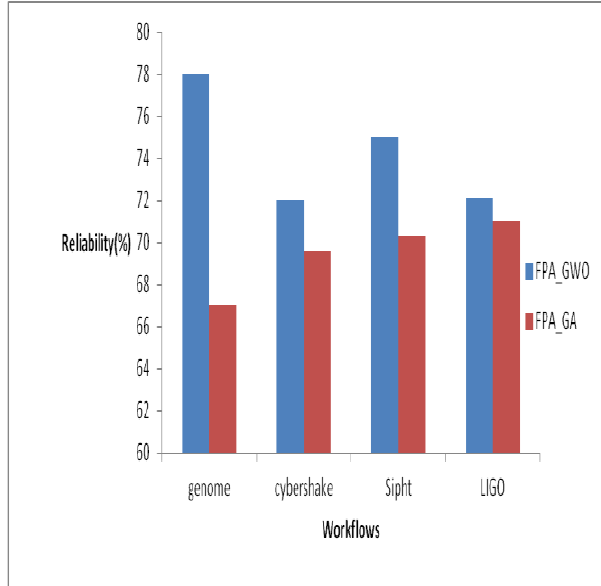
Figure 9. Comparison of Reliability in different